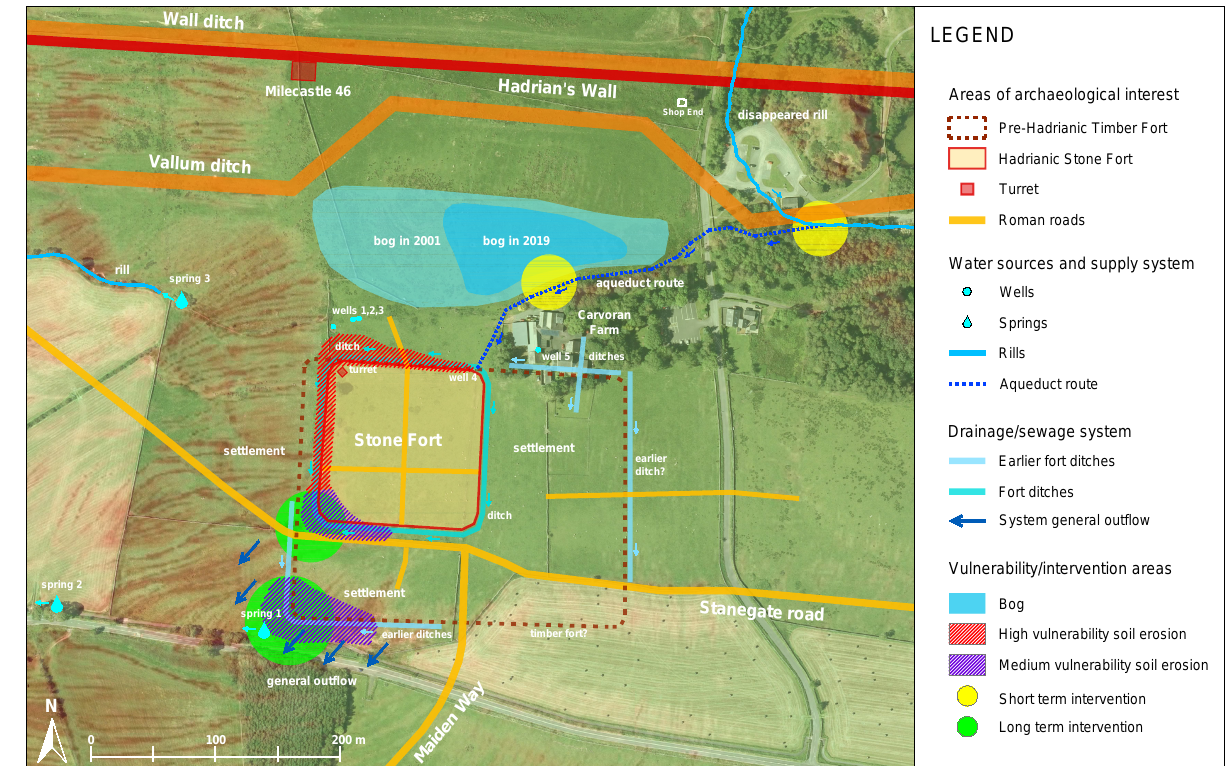
Figure 9. Map of Magna showing the main archaeological and hydraulic systems features. The background is a 2018 drone image, courtesy of the Vindolanda Trust, combined in transparency with the predicted soil erosion map. The site’s vulnerable areas are highlighted, showing high- and medium-soil-erosion-risk areas (in red and purple), and the identified areas that need short or long-term interventions (in yellow and